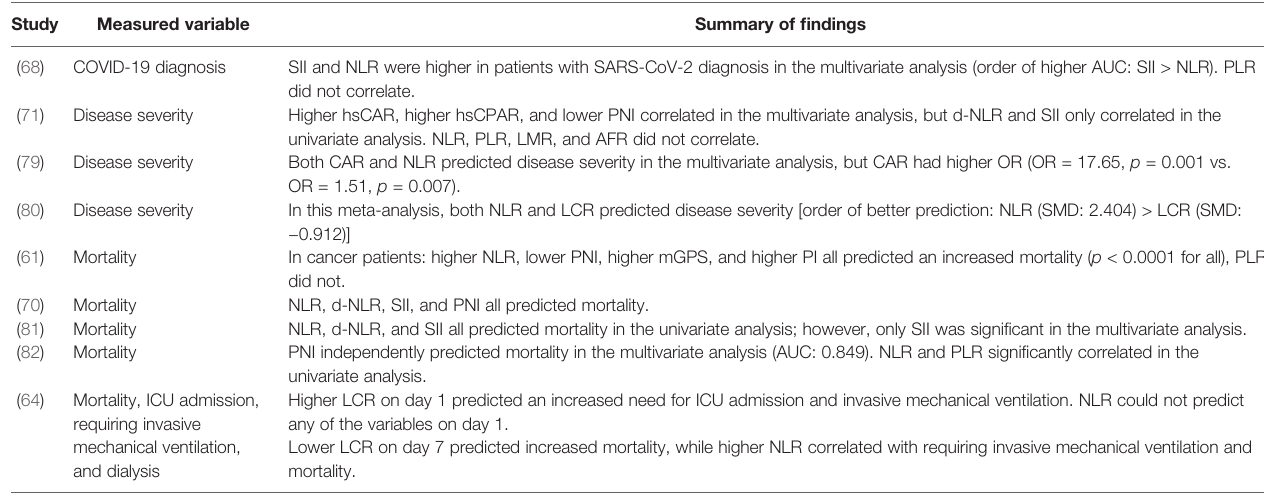
Mortality, ICU admission, requiring